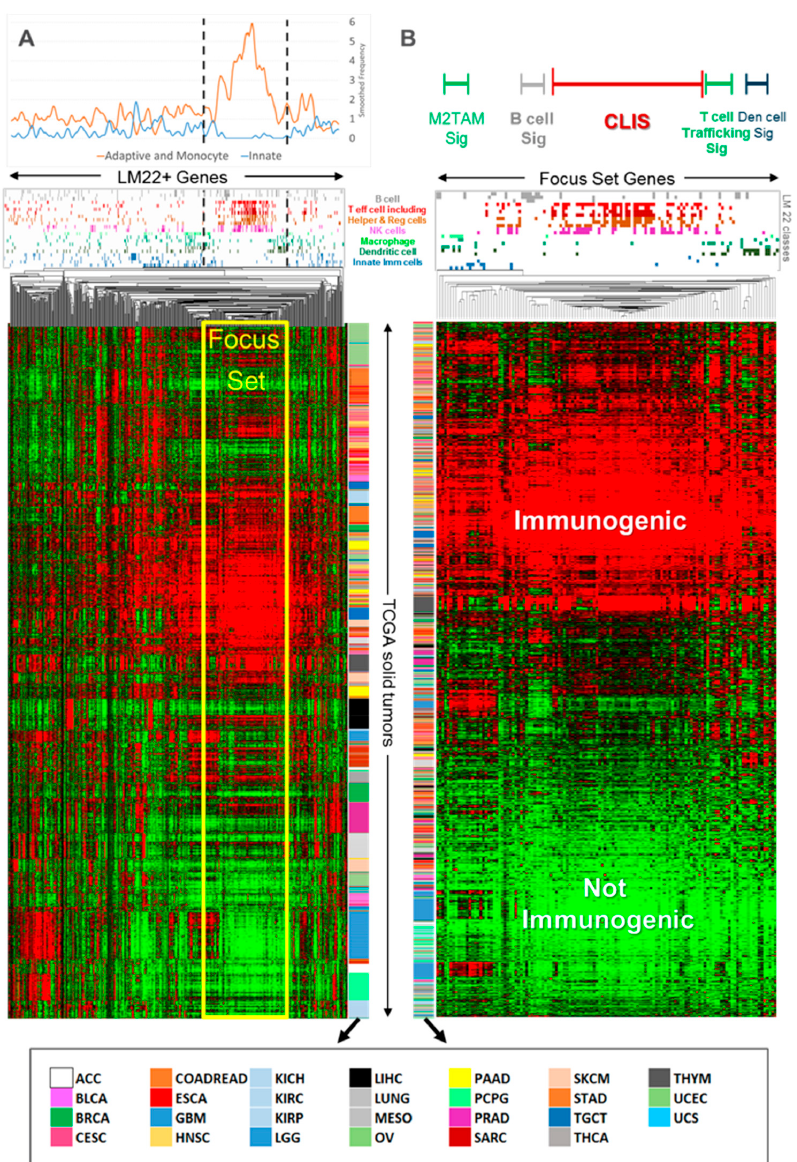
Figure 2. Pan-cancer immunome-clustered heat map of immune-related genes from a stratified uniform sampling of 4446 solid tumor samples. Each tumor specimen is a row and each immunome gene is a column in each heatmap. Each gene is a member of one or more of the immunome 22 classes, where class membership is indicated in the color-coded graph immediately above each heat map. ( A ) denotes a hierarchical clustering where each gene is centered by column. ( B ) denotes the re-clustering of TCGA solid tumor samples using the focus set of 126 genes and annotation of the immune signatures of interest. Abbreviations: CLIS, Cytotoxic Lymphocyte Immune Signature; Den, dendritic; Sig, signature; TAM, tumor associated macrophage. A detailed description of each gene class and its color code